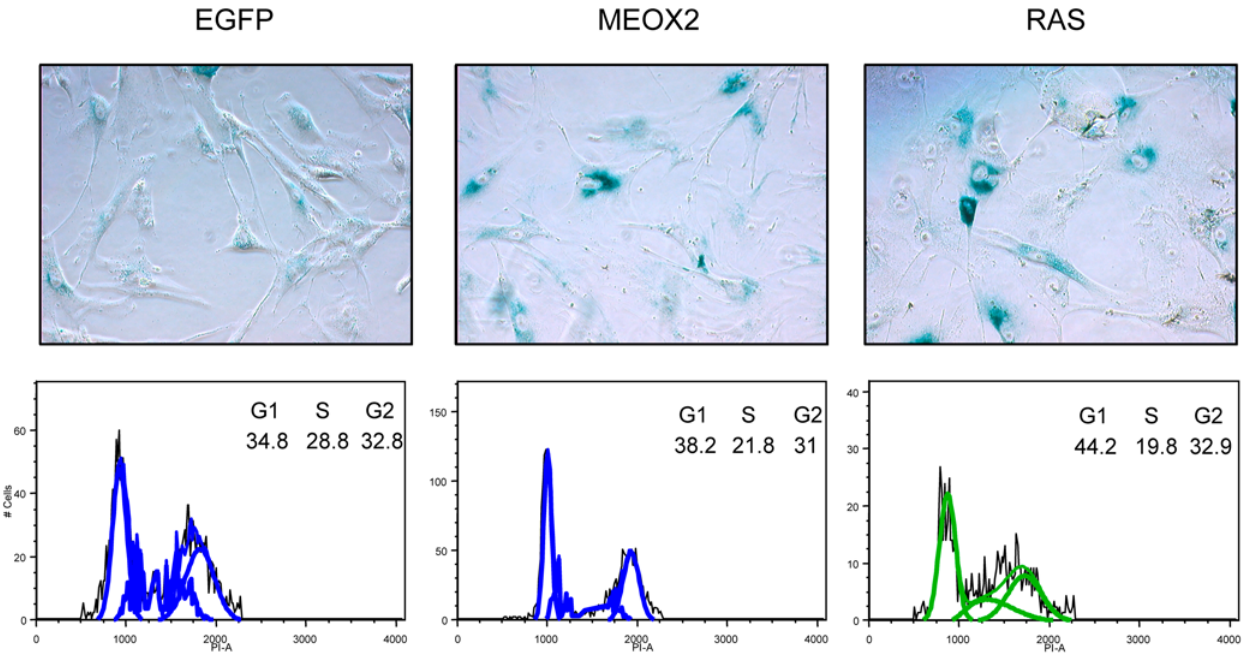
Figure 5. MEOX2 induces senescence phenotypes in primary human fibroblasts. Senescence-associated beta-galactosidase assays were performed on day 13 postselection. FACS analysis reveals accumulation of cells in the G1 phase of the cell cycle in response to MEOX2